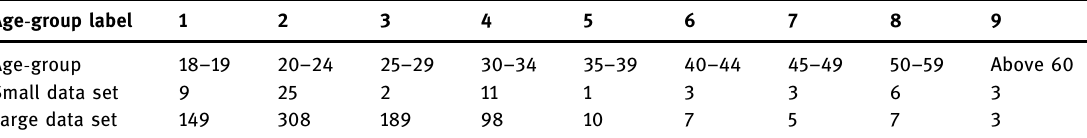
Table 4: The distribution of age - groups in the small data set and the large data set Age - group